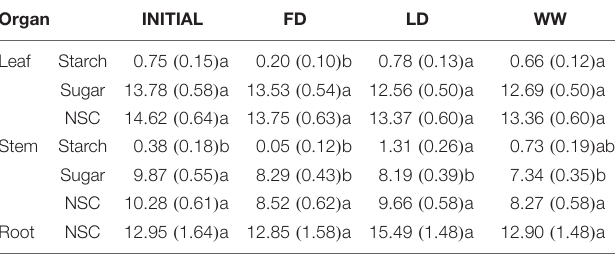
TABLE 2 | Estimated marginal means ( ± 1 standard error) of starch and soluble sugar concentration (% dry weight) for leaf and stem tissue, and of total non-structural carbohydrate (NSC) concentration (% dry weight) of leaf, stem and root (both pots combined) tissue, prior to (INITIAL) and after the three watering treatments (FD, full drought; LD, localized drought; WW, well-watered).